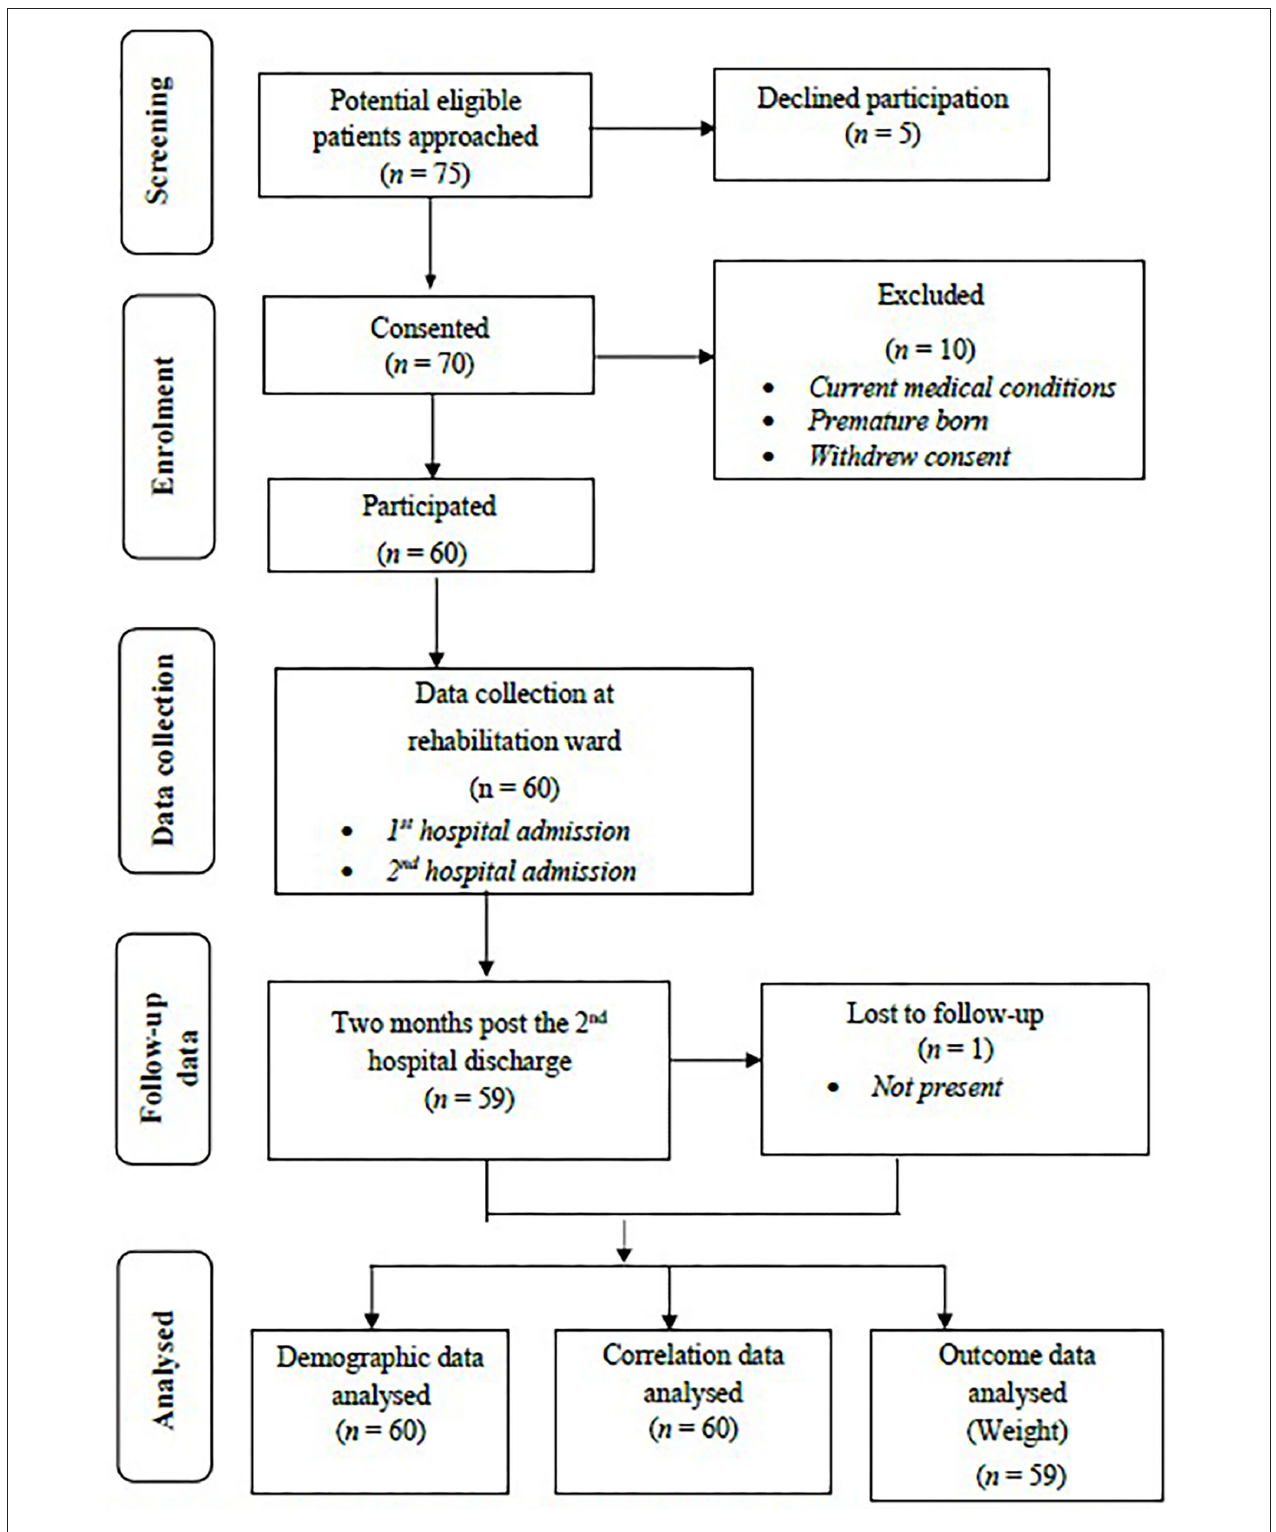
FIGURE 1 | Flow diagram of data